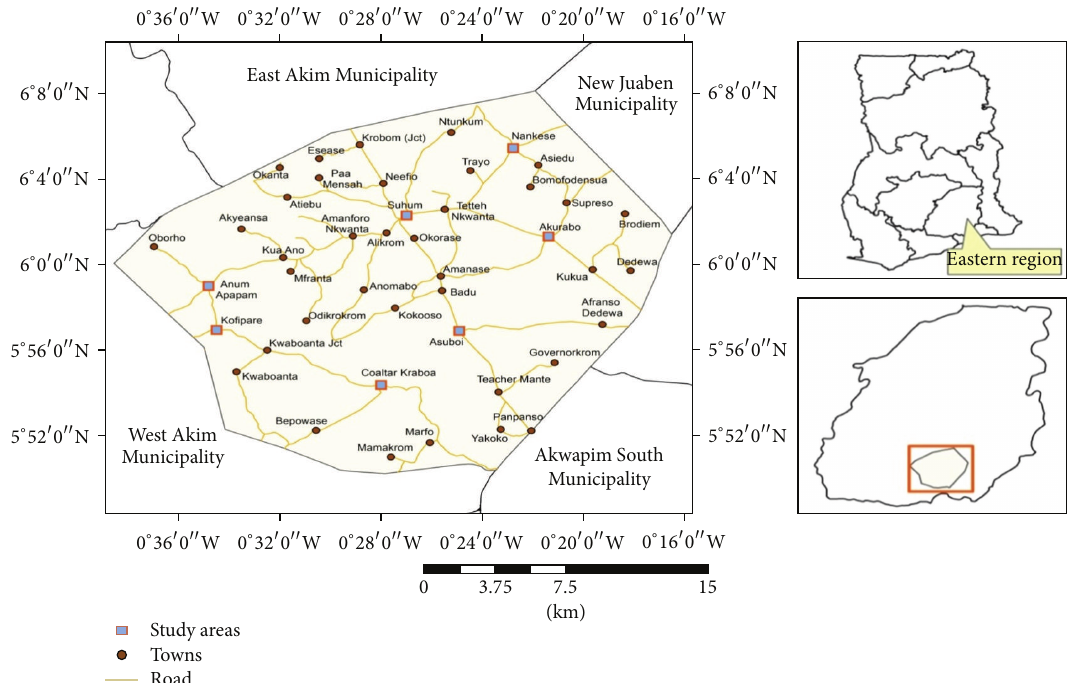
Figure 1: Map of Suhum Kraboa Coaltar District. Source: Cartographic Unit, Department of Geography and Regional Planning, UCC